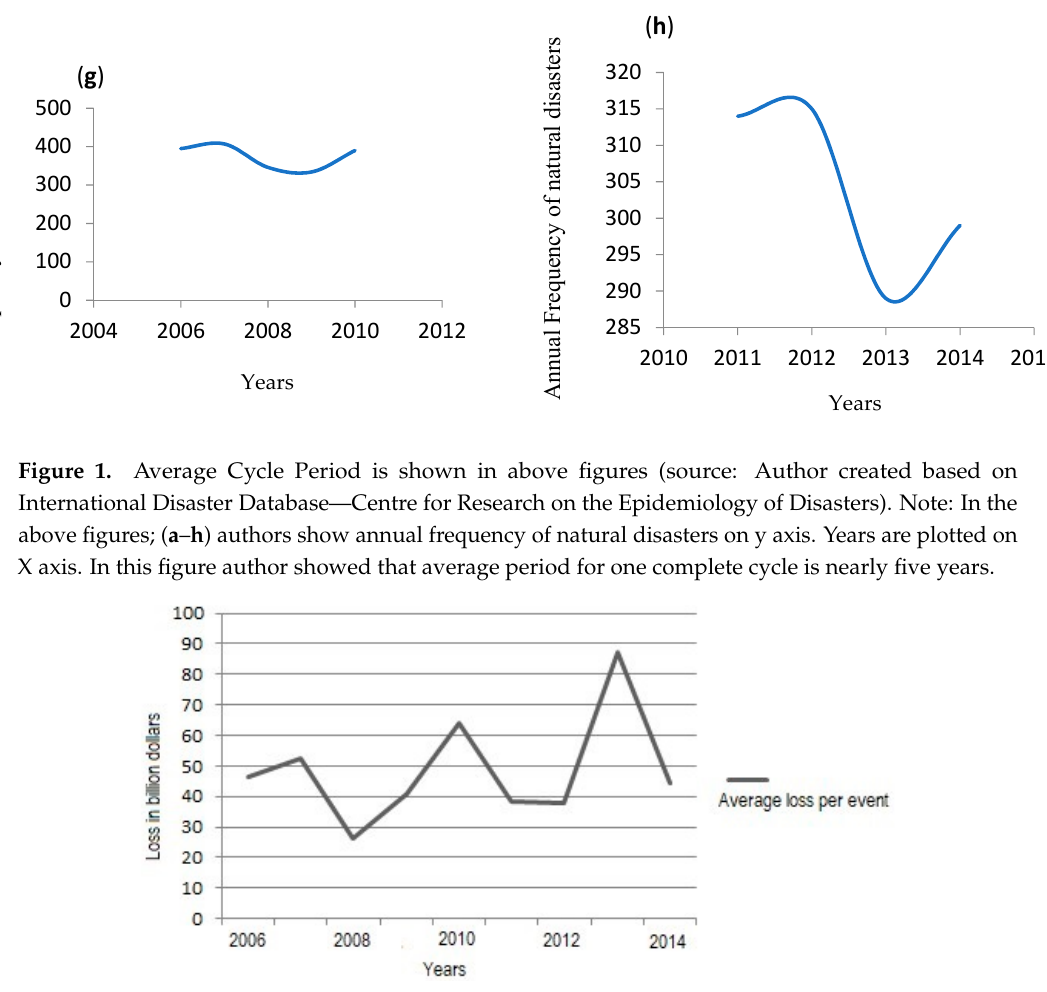
Figure 2. This Figure Shows that average loss per event is increasing every year. Note: In the Figure 2, Y axis shows per annum average loss, whereas, years are depicted on X axis (Source: Author created based on EM-Dat database).